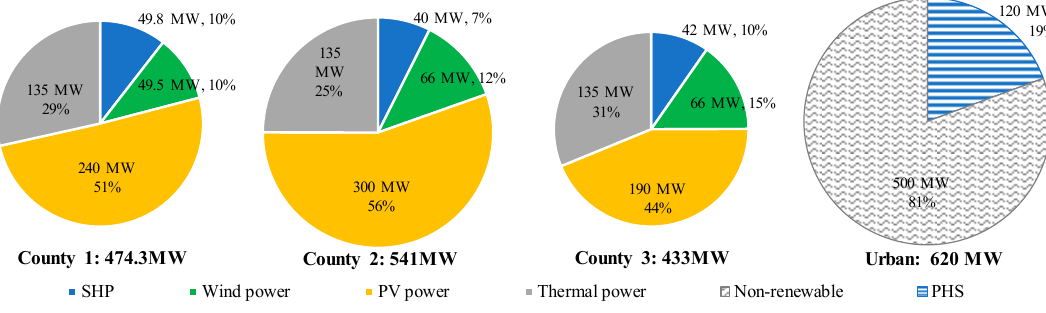
Figure 7. Installed capacity of the power stations.